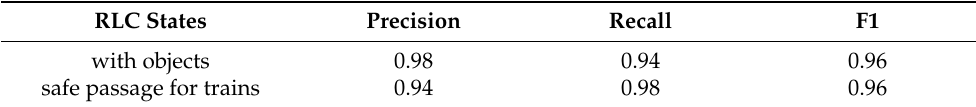
Table 1. Determination of the RLC states using CNN.